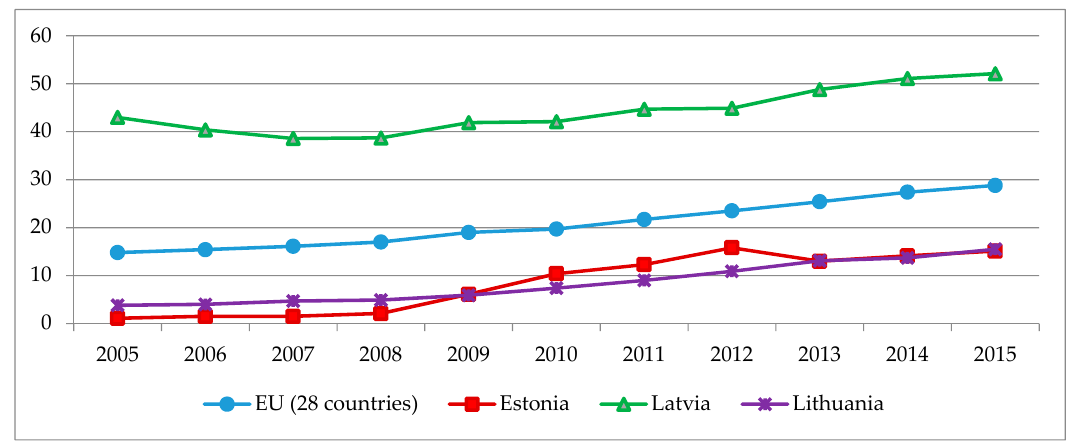
Figure 9. Electricity generated from renewable sources in gross electricity consumption, %.